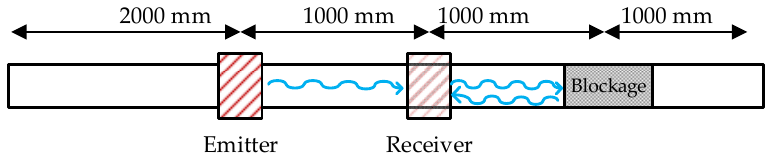
Figure 3. Distances between the emitter, receiver, and blockage.